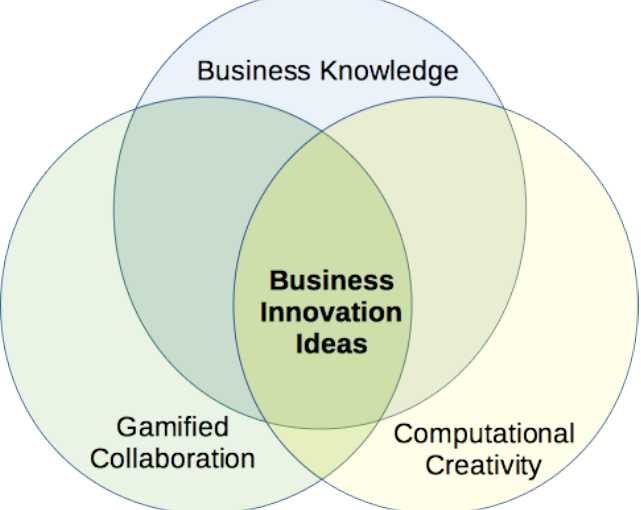
Figure 1. Our approach to business innovation ideas, which requires computational creativity, gamified collaboration, and business